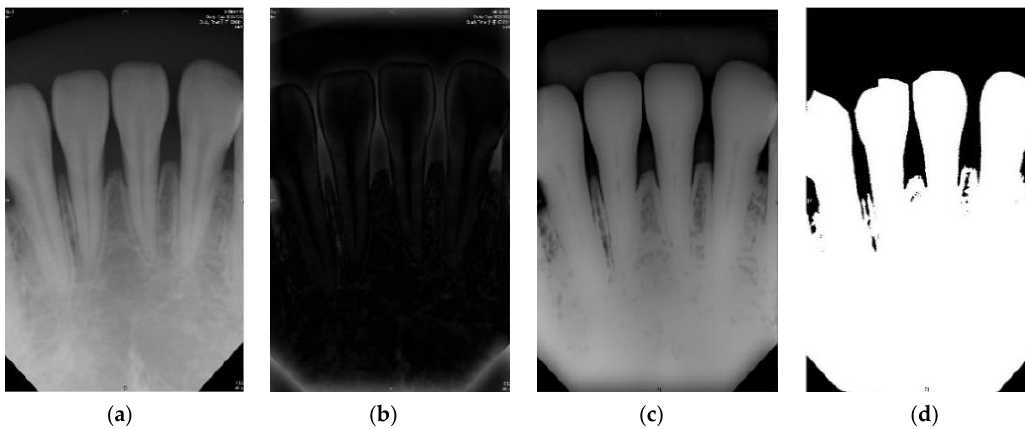
Figure 3. The preprocessed image results of this article. ( a ) Periapical film; ( b ) filtered result of the Gaussian high pass filter; ( c ) difference of ( a ) and ( b ); ( d ) result after the binarization.